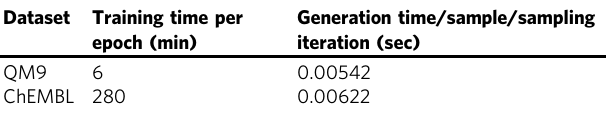
Table 6 Time taken for training and